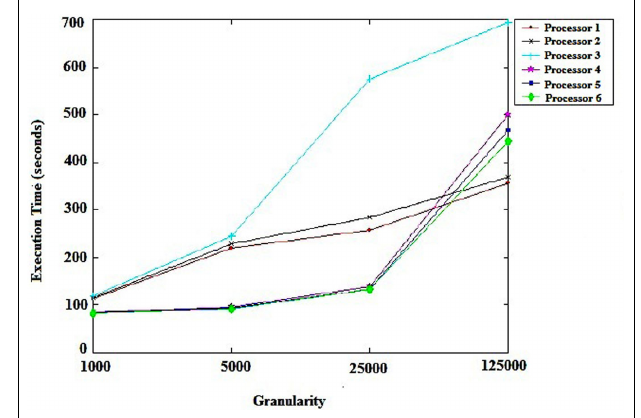
FIGURE 1 | Schedule performance